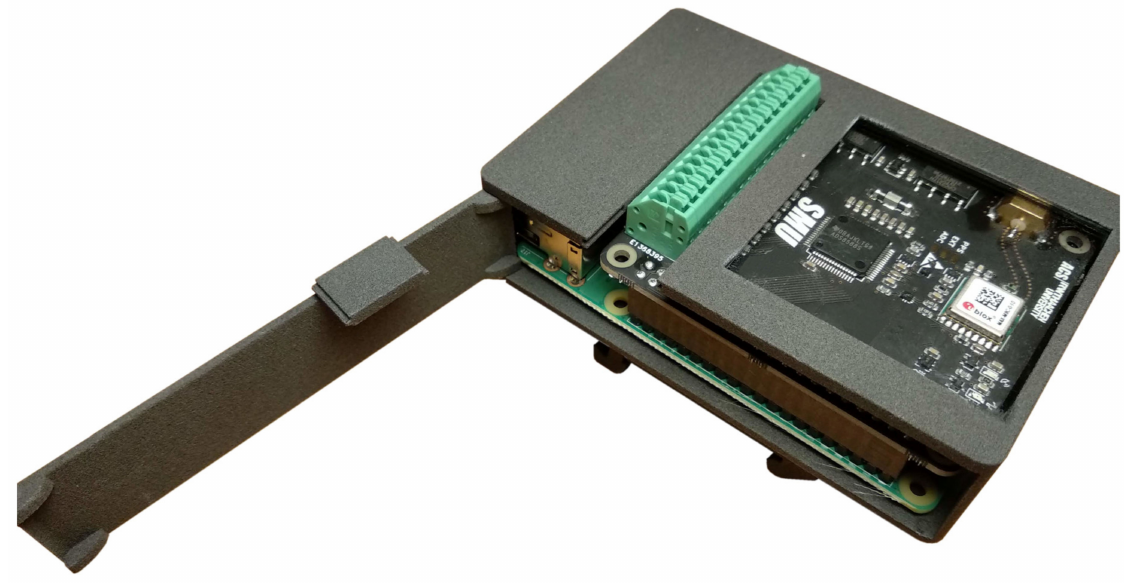
Figure 3. View of the 3D printed SMU enclosure; the side opening allows to easily slide inside/outside the Raspberry Pi with the smuHAT installed on